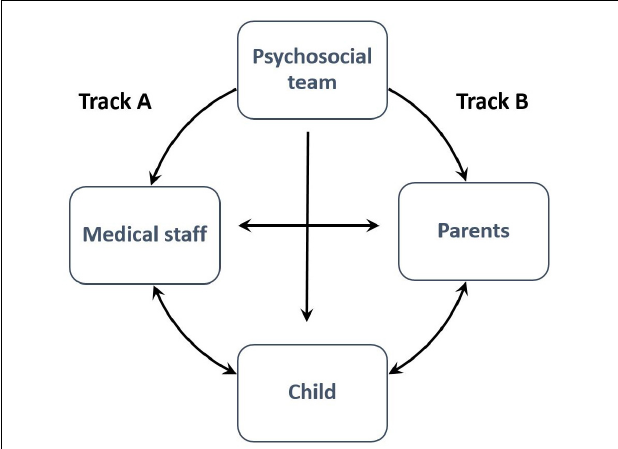
FIGURE 1 | A proposed holistic model of